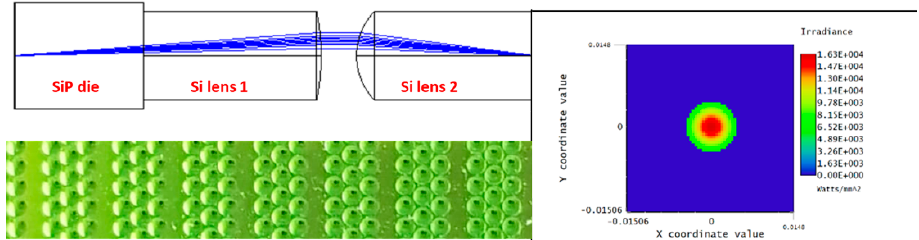
Figure 21. The optical design of the 2-lens relay over a 10° grating coupler through the silicon substrate. The optical ray trace is shown in the upper figure and the fiber coupling efficiency from beam propagation on the right side. The lower image shows the bottom silicon lens array. Additional lenses are added to the 2 × 8 array for mechanical support and process integrity.